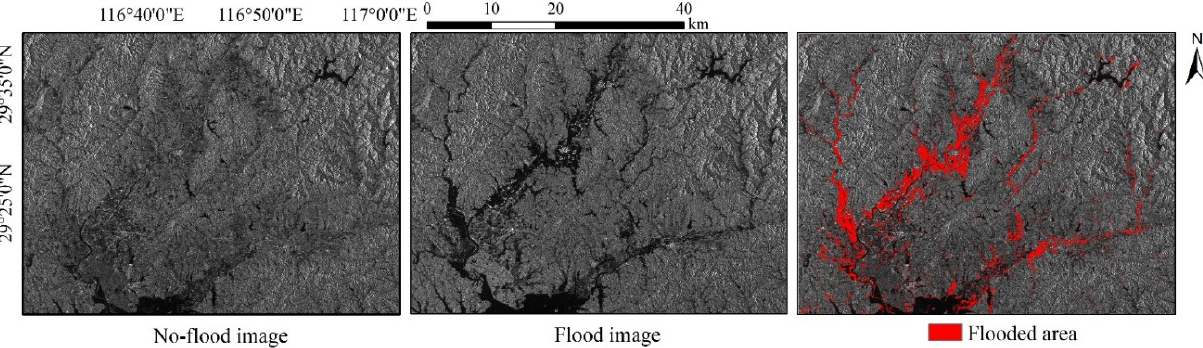
Figure A4. Flood detected in Xinmiao Lake in 2020.